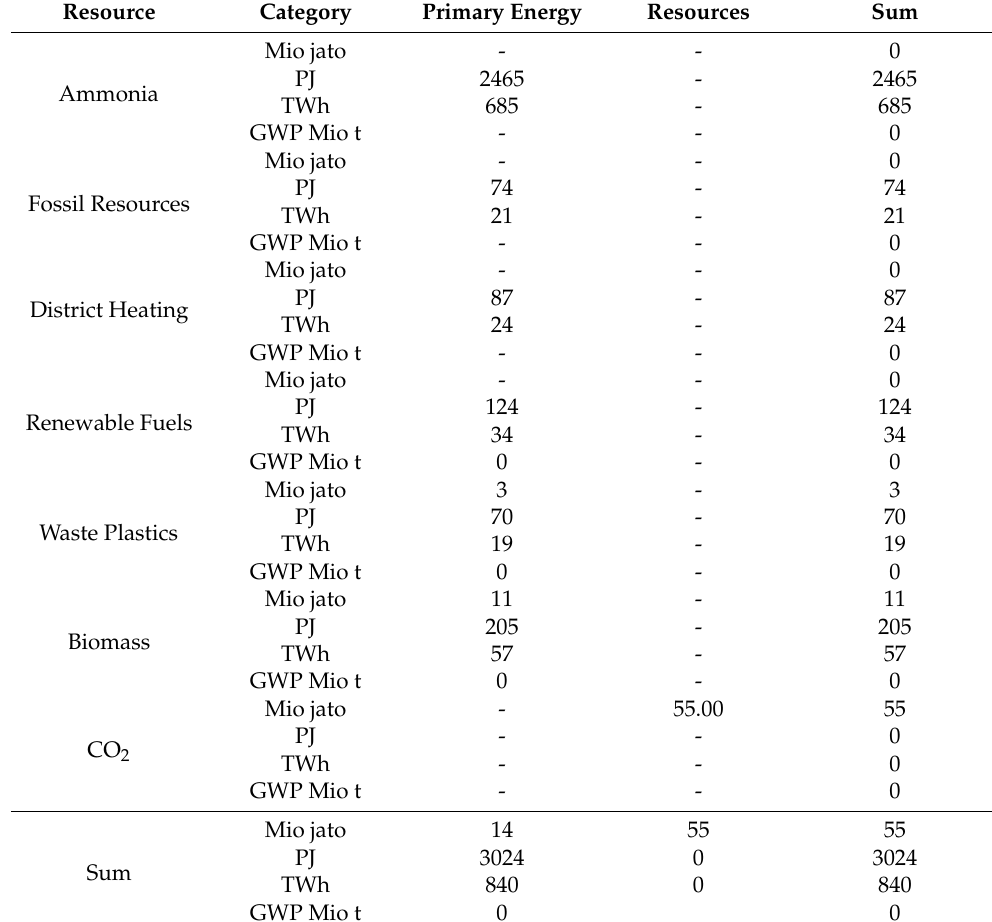
Table 3. Inlet mass and energy streams of German Chemical–Pharmaceutical Industry in 2050.